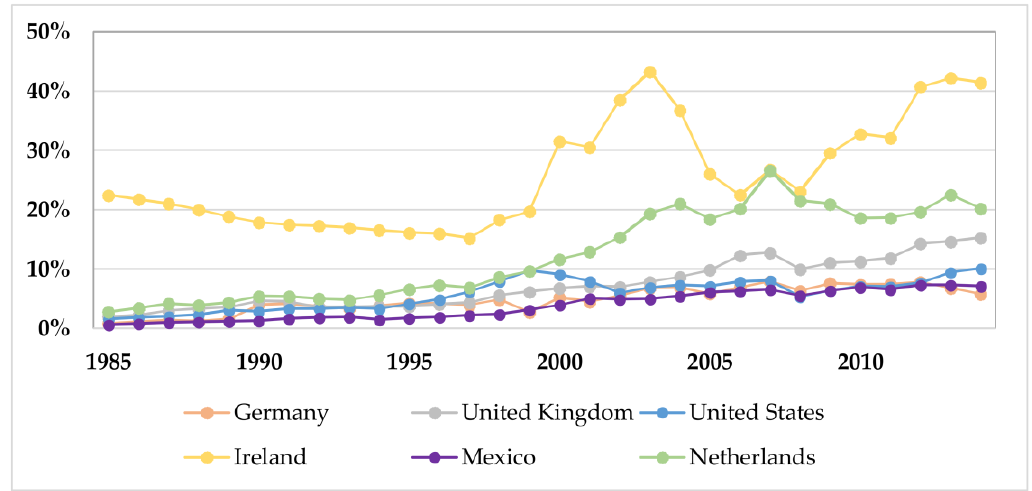
Figure A2. FDI Inward Stock as Percentage of National Capital Stock. Source: UNCTAD. Table A1. Correlation matrix for selected explanatory variables to FDI flow.